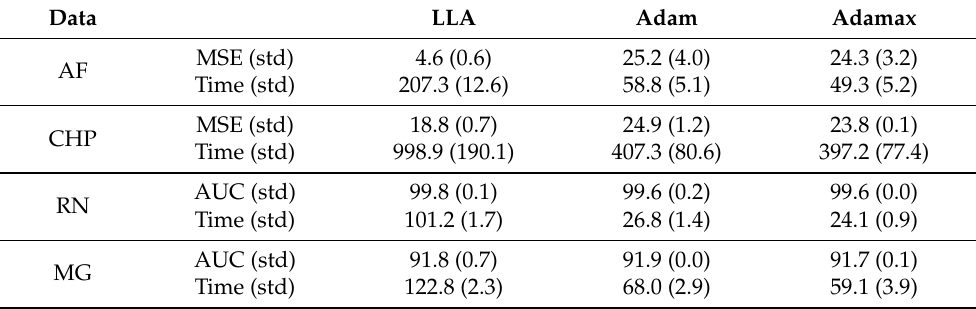
Table 4. Training time and accuracy (testing MSE/AUC for regression/classification problems) of LLA, Adam, and Adamax. For AF and CHP (regression) data sets, the training epoch is fixed at 1000. For RN and MG (classification) data sets, the training epoch is fixed at 150. MSE(std) and AUC(std) in this table denote 100 times of the average(standard deviation) of MSE/AUC values over epochs. Time is measured in seconds. Data LLA Adam